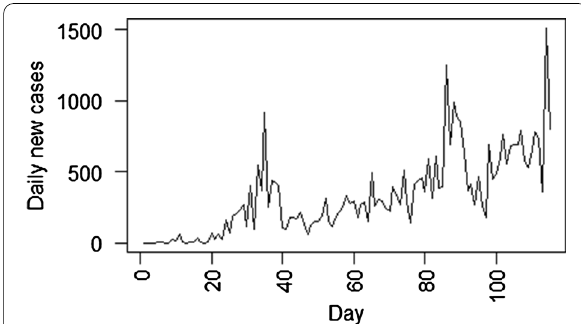
Table 1 Descriptive statistics of daily new cases of COVID-19 and the weather variables